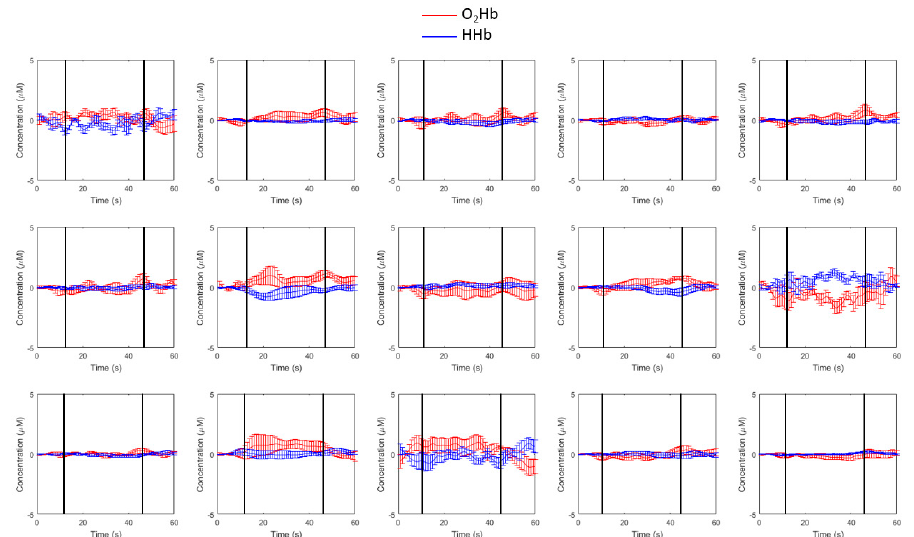
Figure 2. The 5 blocks average time-course response of changes in levels of oxyhemoglobin (O 2 Hb) and deoxyhemoglobin (HHb) in a single subject for the Silent Word Generation (SWG) task. The black vertical lines represent the start and the end of the task.